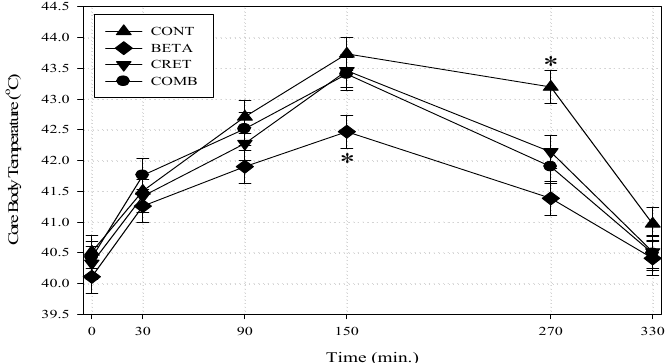
Figure 1. Core body temperatures (°C) of acutely heat-challenged broiler chicks treated with dietary betaine (B; 1 g / kg diet), creatine (C; 1.2 g / kg diet) or B + C combination (Betaine and Creatine group: